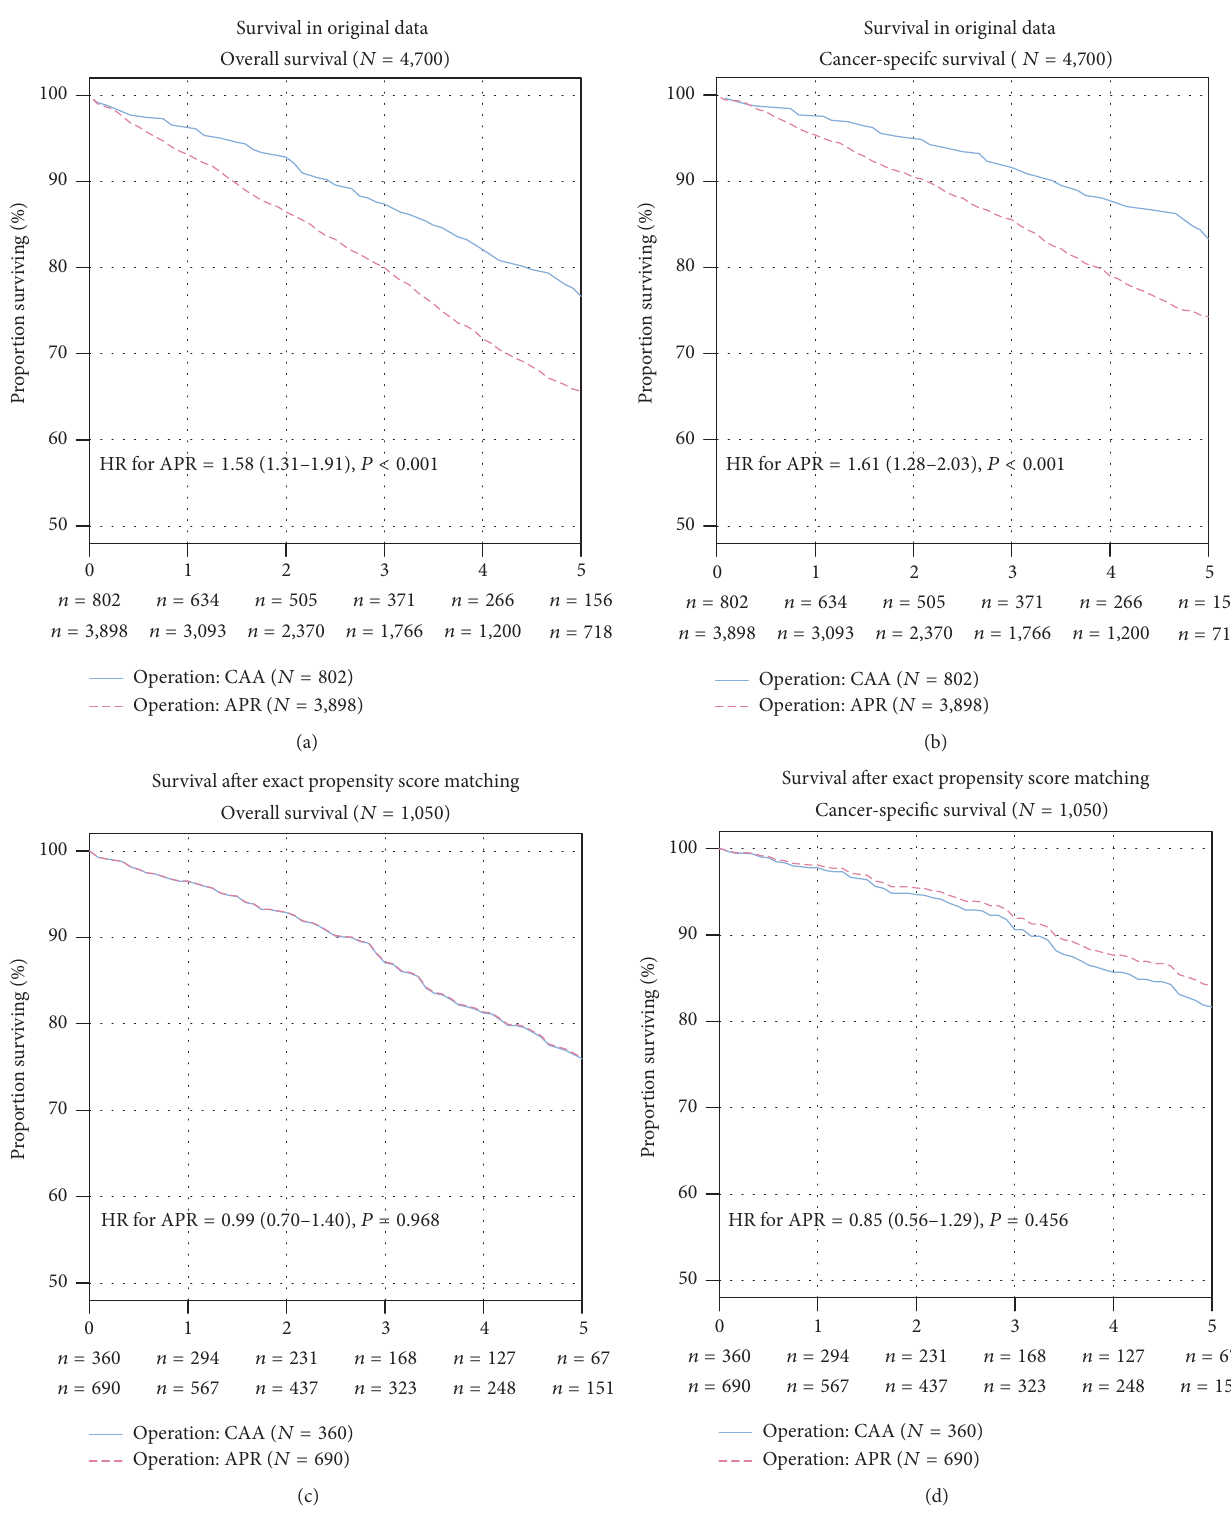
Figure 2: Kaplan-Meier curves for overall (panels a, c) and cancer-specific (panels b, d) survival in unadjusted and propensity score adjusted analysis. The overall survival (panels a, c) and cancer-specific survival (panels b, d) in unadjusted and propensity score adjusted analysis are depicted. The number of rectal cancer patients at risk in the two groups is given below each plot. HR: hazard ratio for APR compared with CAA with 𝑃 value from likelihood-ratio